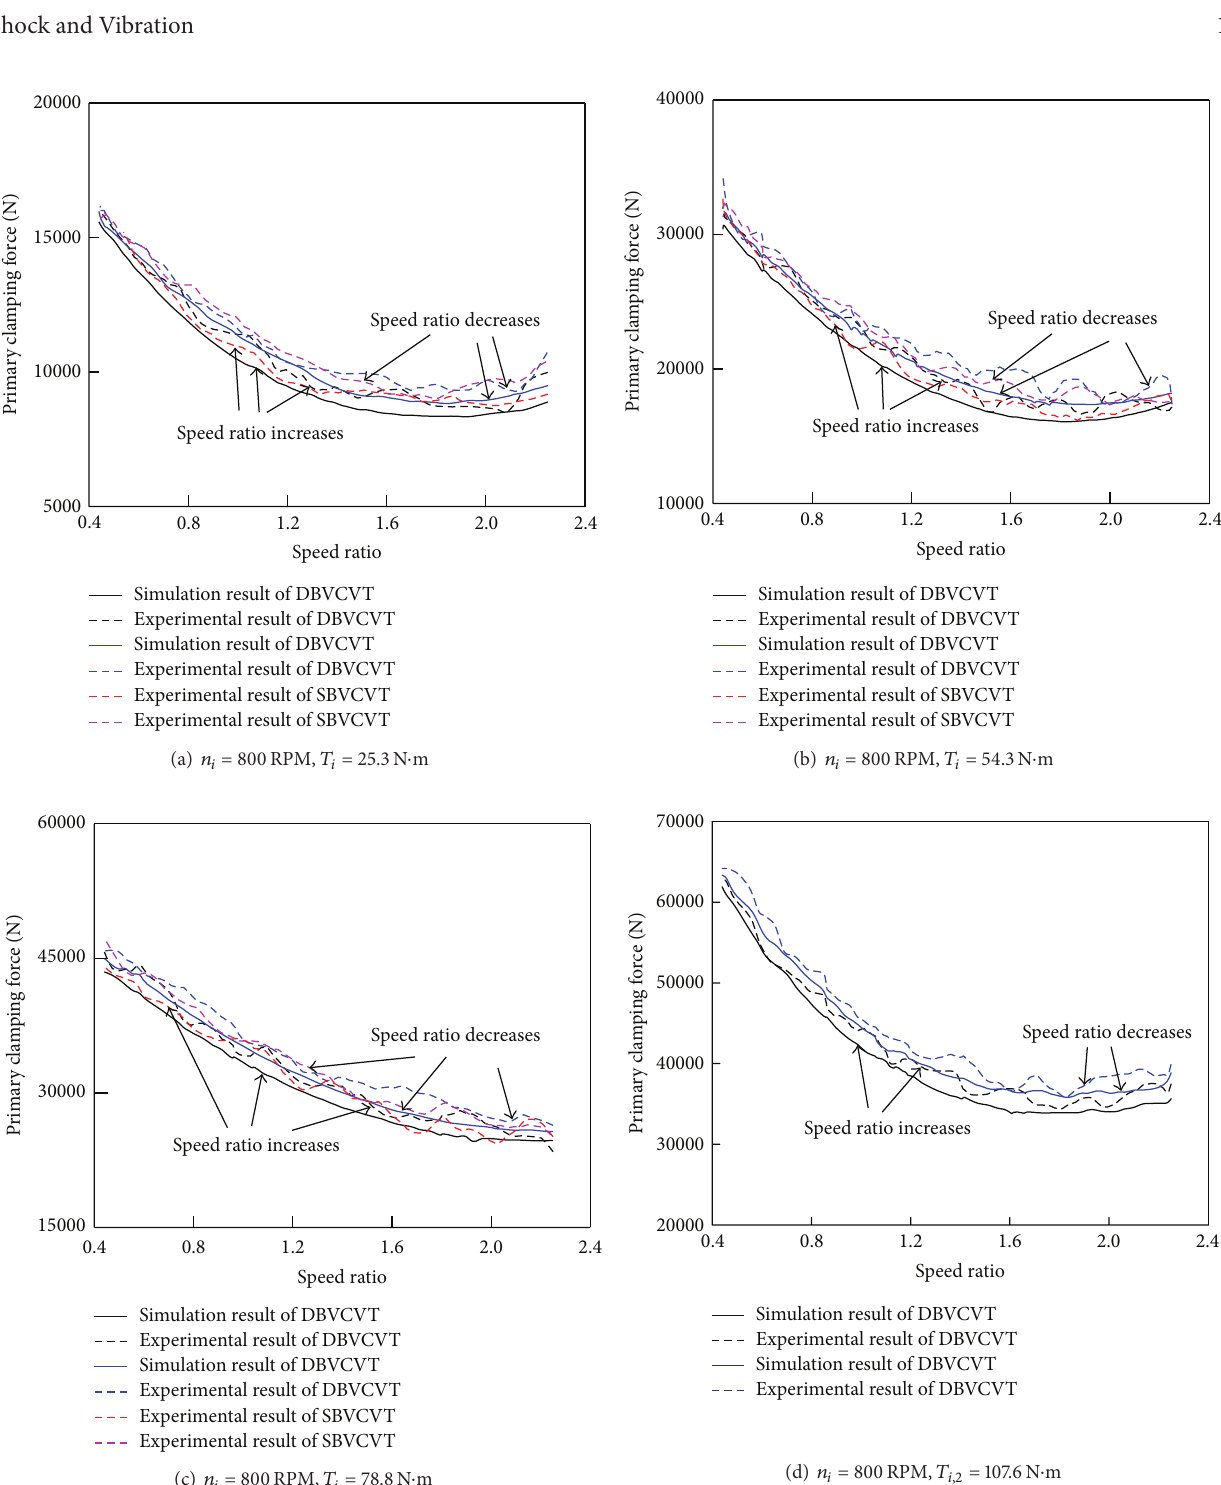
comparison of simulation and experimental results of speed ratio response of DBVCVT under different test